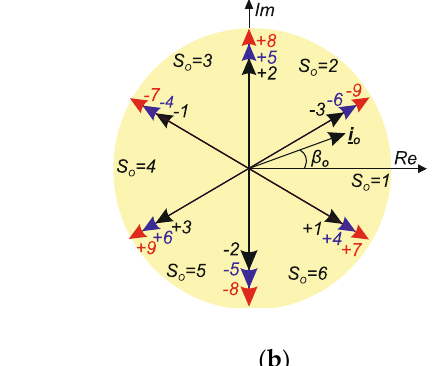
Figure 3. Geometric interpretation of the used switch configurations in Current Source Matrix Converter (CSMC) . Table 2. Acceptable switch configurations in Space Vector Modulation (SVM) for CSMC.